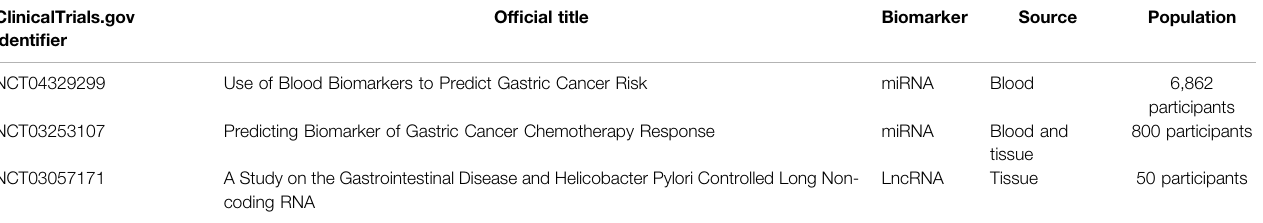
TABLE 3 | Clinical trials of ncRNAs in